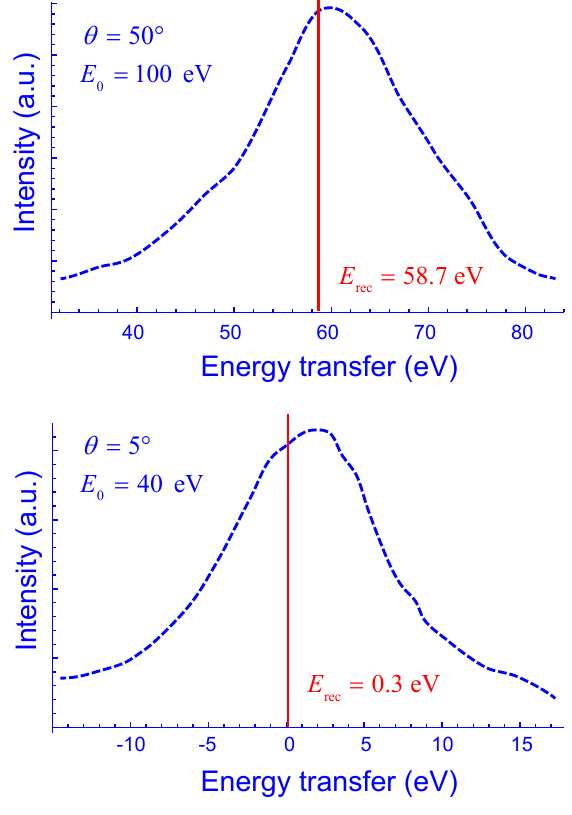
Figure 3: Schematic representation of two examples of deep- inelastic neutron scattering spectra from a solid polymer (polyethylene, [ − CH 2 − ] n ) measured with the time-of-flight spectrometer MARI of ISIS [54]. Peak-shifts to higher en- ergy transfers than the conventionally expected recoil energy E rec (vertical red lines) are clearly visible. This corresponds to a lower e ff ective mass of the recoiling H; see the text. For experimental details and more examples, see